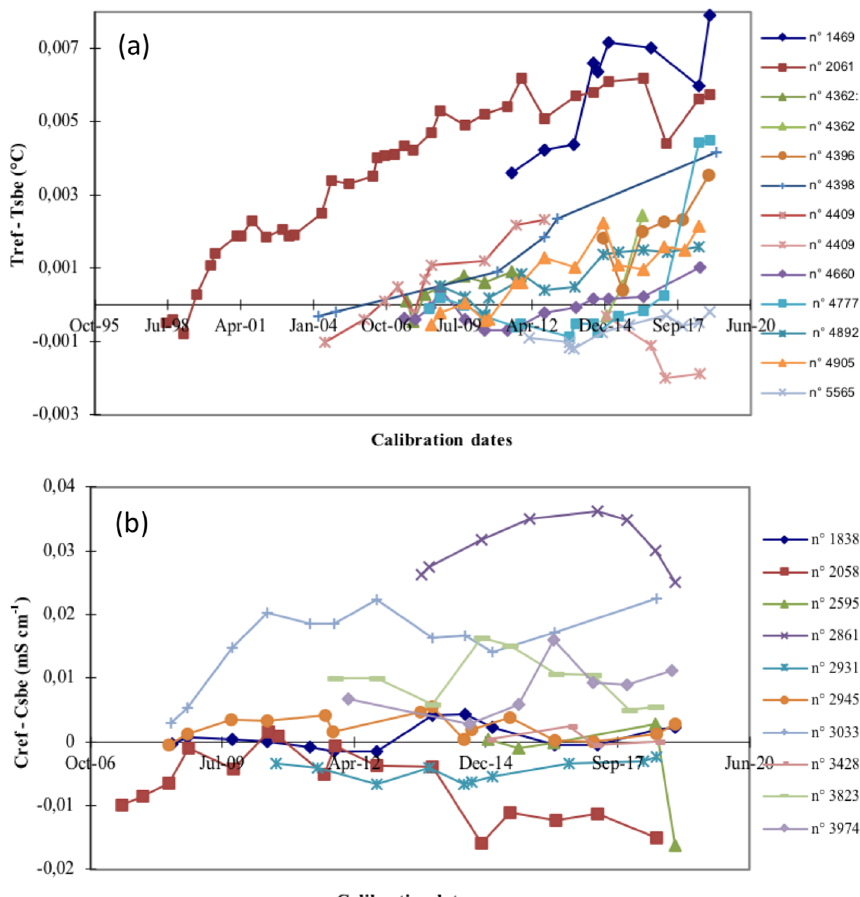
Figure 3. (a) Review of corrections applied on data at 15 ◦ C, after the calibrations of SBE-3 sensors. (b) Review of corrections applied on data at 40mScm − 1 , after the calibrations of SBE-4